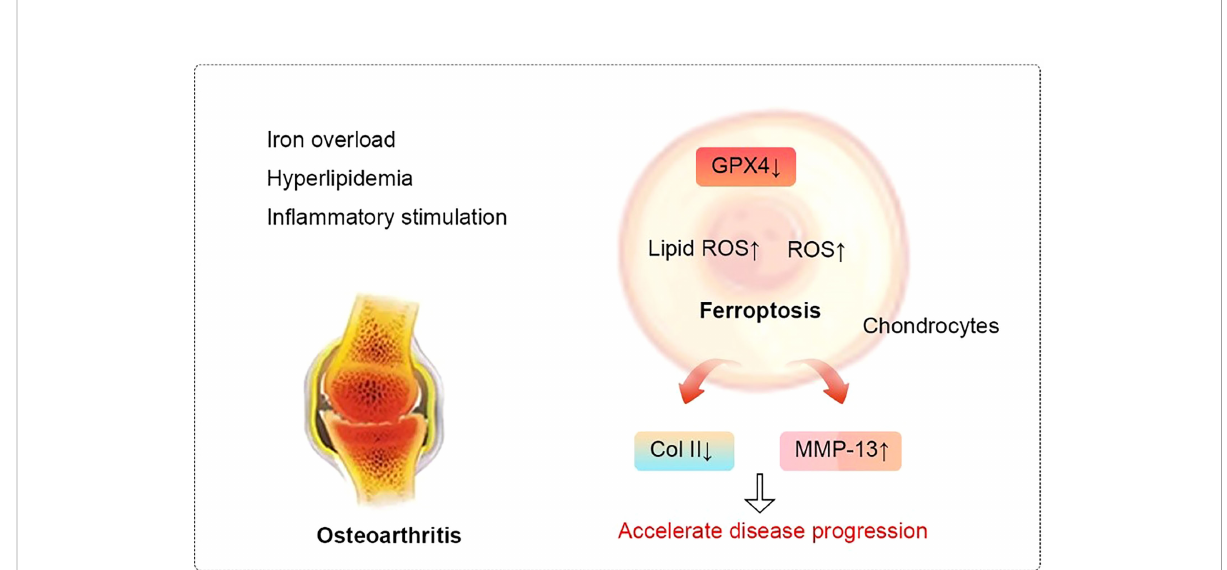
FIGURE 5 Relationship between ferroptosis and osteoarthritis. In cellular environments stimulated by iron overload, hyperlipidemia, and in fl ammation, the expression of Gpx4 in chondrocytes decreases. These changes lead to the accumulation of reactive oxygen species and lipid peroxides to ultimately induce ferroptosis. Ferroptosis, in turn, can progressively exacerbate the in fl ammatory response, leading to the increased expression of MMP-13 and decreased expression of collagen II in chondrocytes to accelerate the progression of OA. Abbreviations: ROS, reactive oxygen species; Col II, Type II collagen; MMP-13, matrix